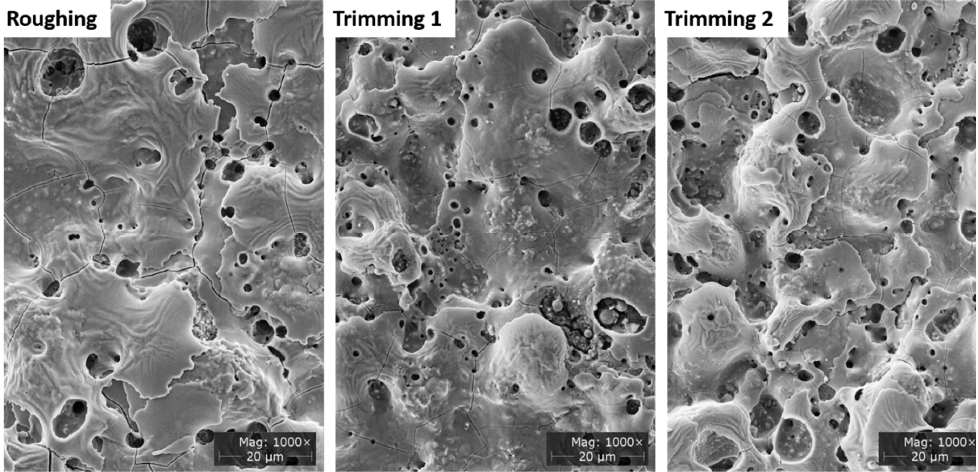
Figure 7. SEM images showing details of ZTA-TiN surfaces ED-machined with different parameter sets. Table 2. Roughness values for ED-machined surfaces.